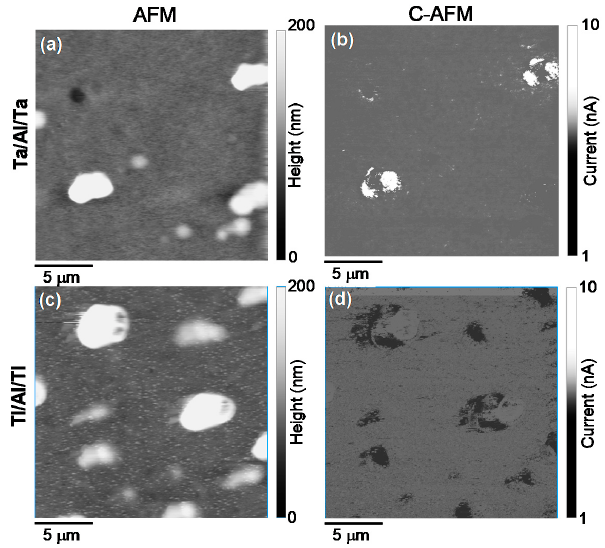
Figure 4. AFM image and Conductive Atomic Force Microscopy (C-AFM) map acquired on contacts: ( a ) AFM image and ( b ) associated C-AFM map acquired on Ta/Al/Ta contact. ( c ) AFM image and ( d ) associated C-AFM map acquired on Ti/Al/Ti contact. The images were acquired on 20 µm × 20 µm scan